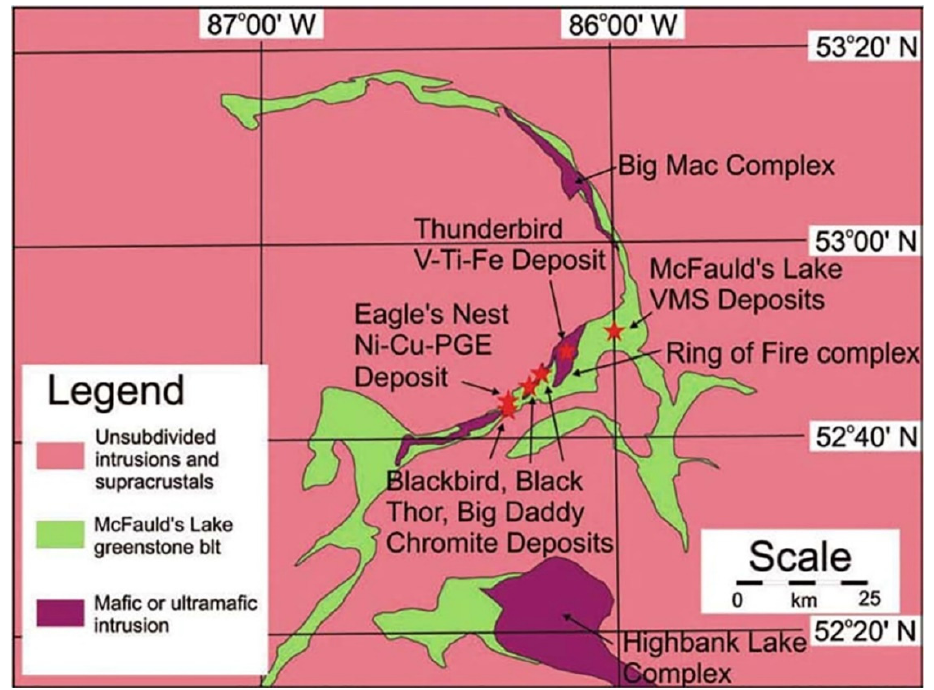
Figure 4. Geological map of the Ring of Fire area with marked known deposits (from [20]).